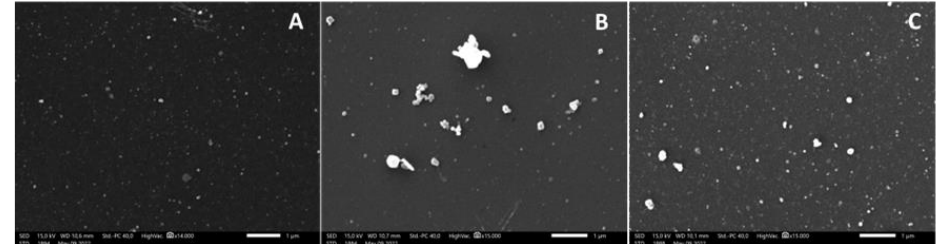
Figure 11. SEM images of original and rehydrated liposomes in SSF and PBS from in vitro assays (( A ) original liposomes; ( B ) SSF from swelling assay; ( C ) PBS from release assay).